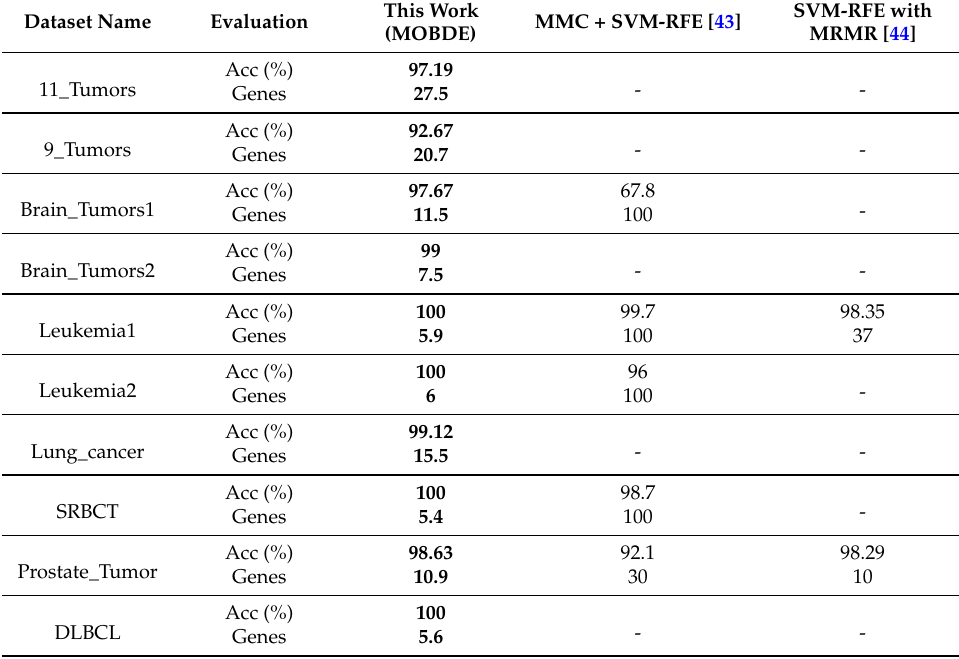
Table 12. Comparative experimental results of the binary differential evolution algorithm with MOBDE with The maximum margin criterion and support vector machine-based recursive feature elimination (MMC + SVM-RFE), support vector machine-based recursive feature elimination (SVM-RFE) and minimum-redundancy maximum-relevancy